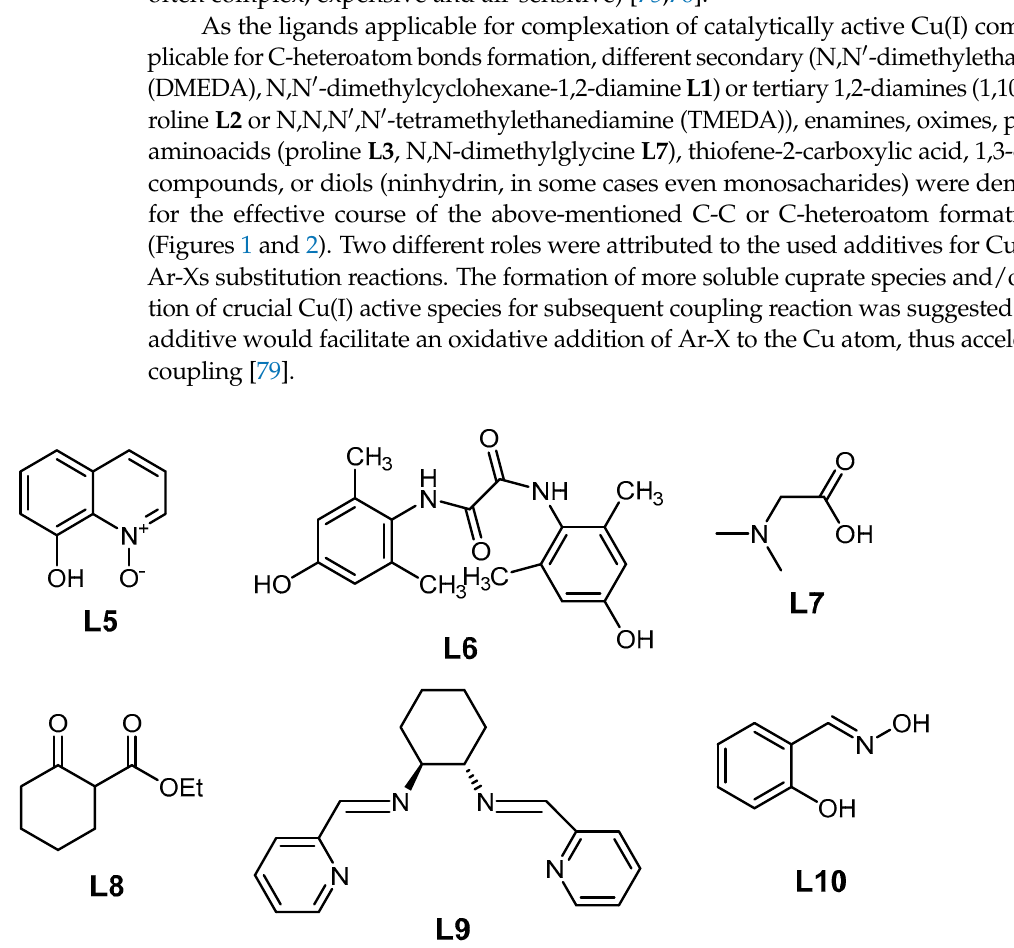
Figure 2. Commonly used ligands applied for Cu-catalyzed Ullmann